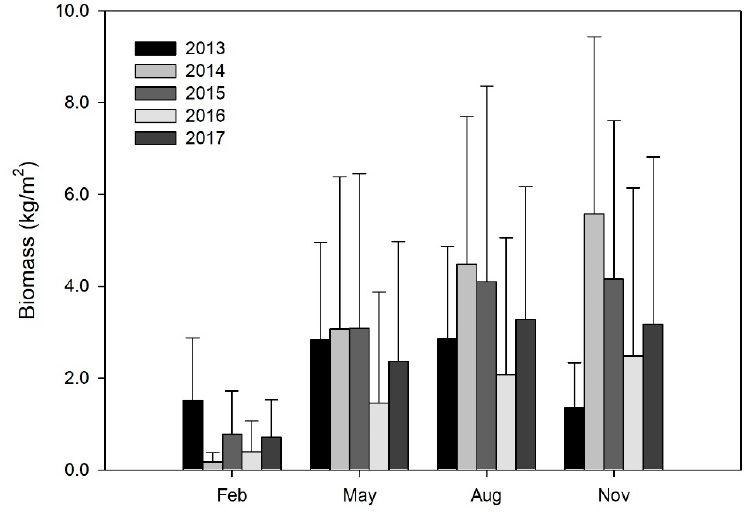
Vertical bars indicate